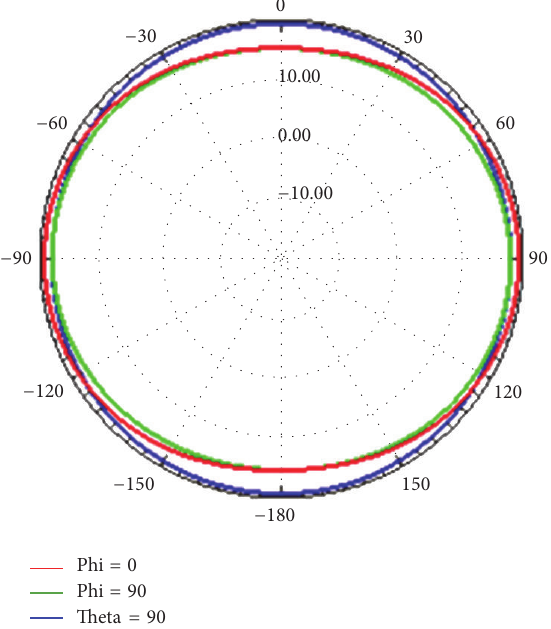
Figure 20: Radiation patterns ( 𝐸 total ) in 2D of 3D spherical antenna (Table 7) in the plans: 𝑥𝑧 , 𝑦𝑧 , and 𝑥𝑦 .